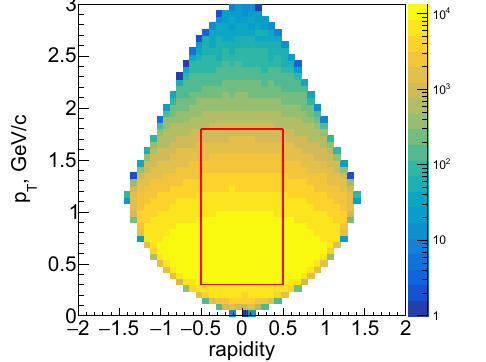
Figure 7: Proton number distributions measured at